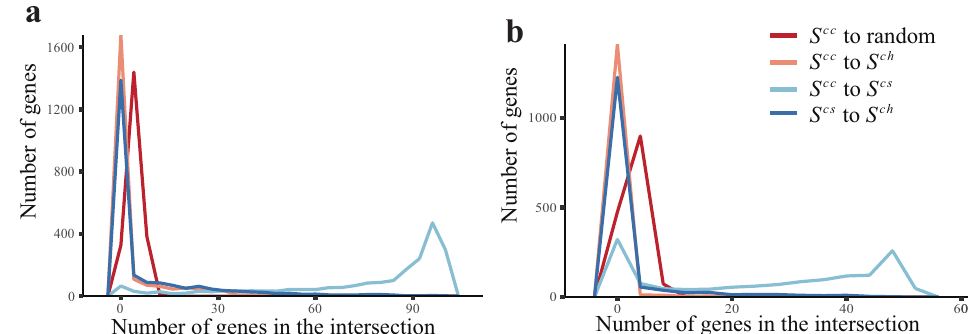
Figure 5. The distribution of intersections as measured by different methods in two data sets. We compared the most correlated genes derived from X cur , X cha , and X sub . Pearson’s correlation coefficient is used to describe three different correlations: (i) correlation between X cur and X cur i j (denoted as cur_cur), (ii) correlation between X cur and X sub (denoted as cur_sub), and (iii) correlation i j between X cur and X cha (denoted as cur_cha). For each gene, 100 genes with the largest (50 positive i j and 50 negative) cur_cur, cur_sub, or cur_cha values were collected into three gene sets S cc , S cs , and S ch , respectively. We recorded the number of genes in the intersections between the three sets. In addition, we recorded the intersection between S cc and 100 randomly selected genes as